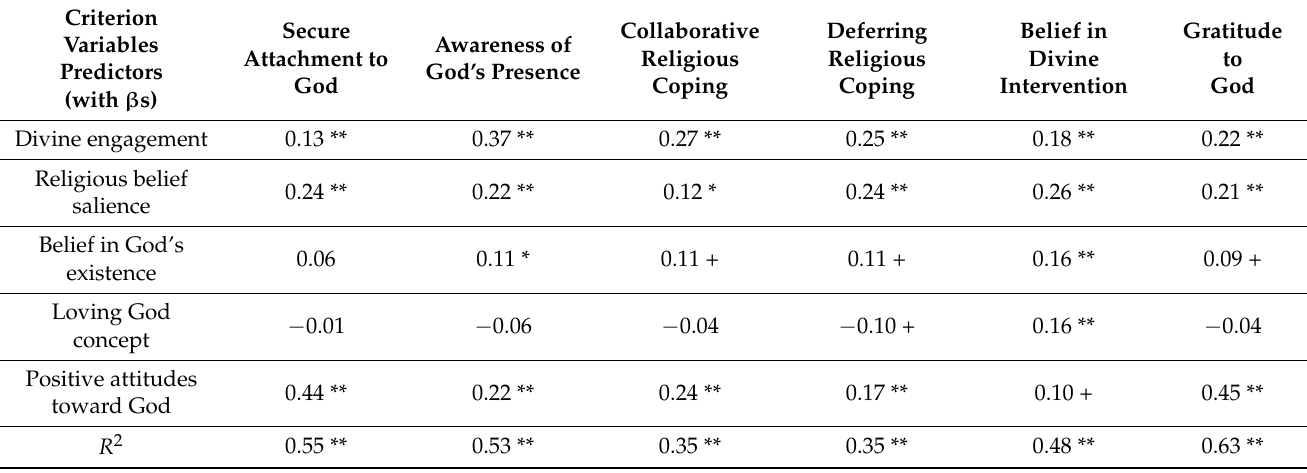
Table 9. Predicting Positive God-Related Variables from Divine Engagement and Other Indicators of a Positive Relationship with God: Simultaneous Regressions.